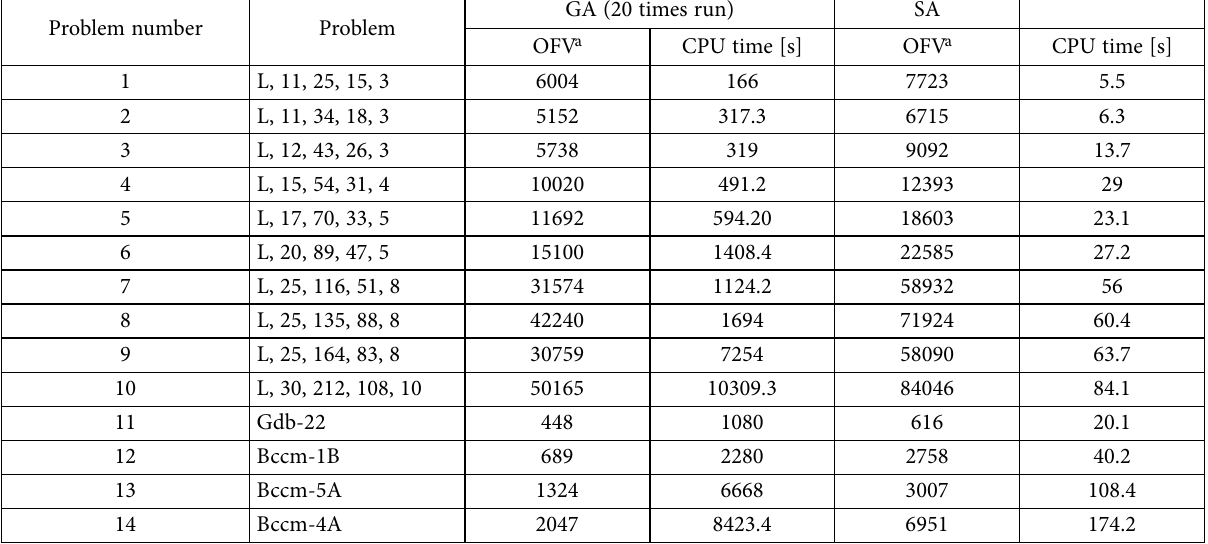
Table 9. The results of GA and SA approaches for large-sized instances Problem